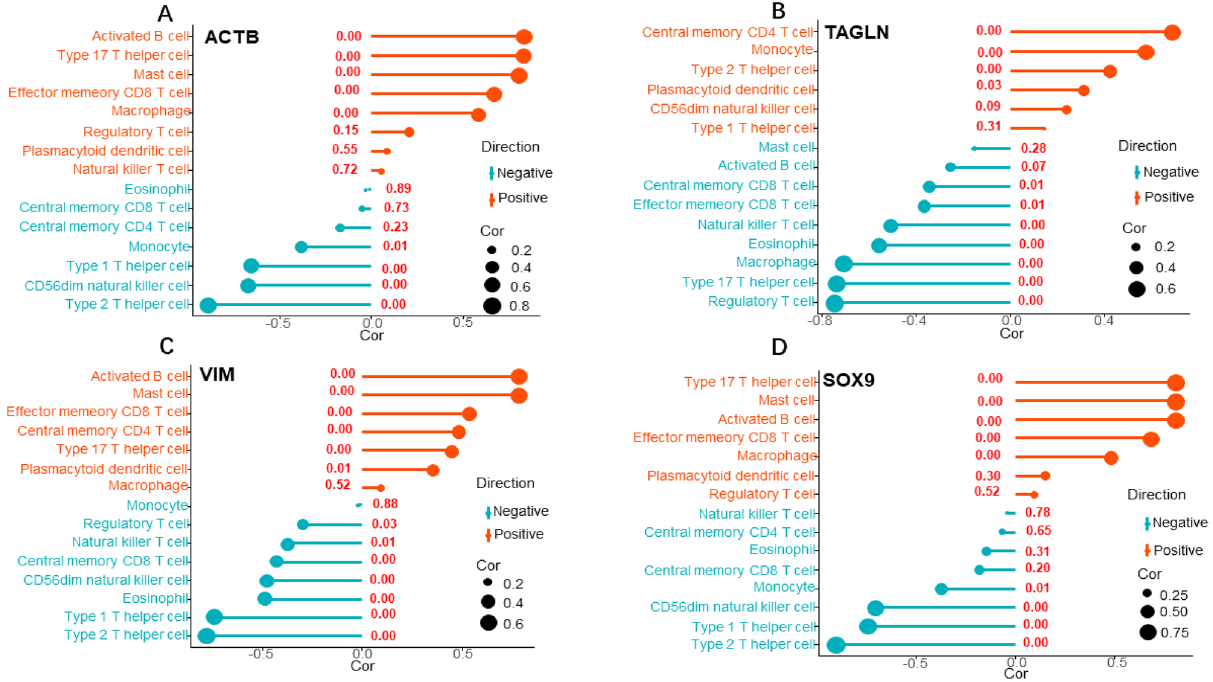
between VIM and infiltrating immune cells. ( D ) Correlation between SOX9 and infiltrating immune cells. Size of the dot represents the strength of the correlation between key immune related genes and immune cells; the larger (or smaller) the dot is, the stronger (or weaker) the correlation is. Color of the dot represents the negative or positive correlation; green: negative correlation, red: positive correlation. The number